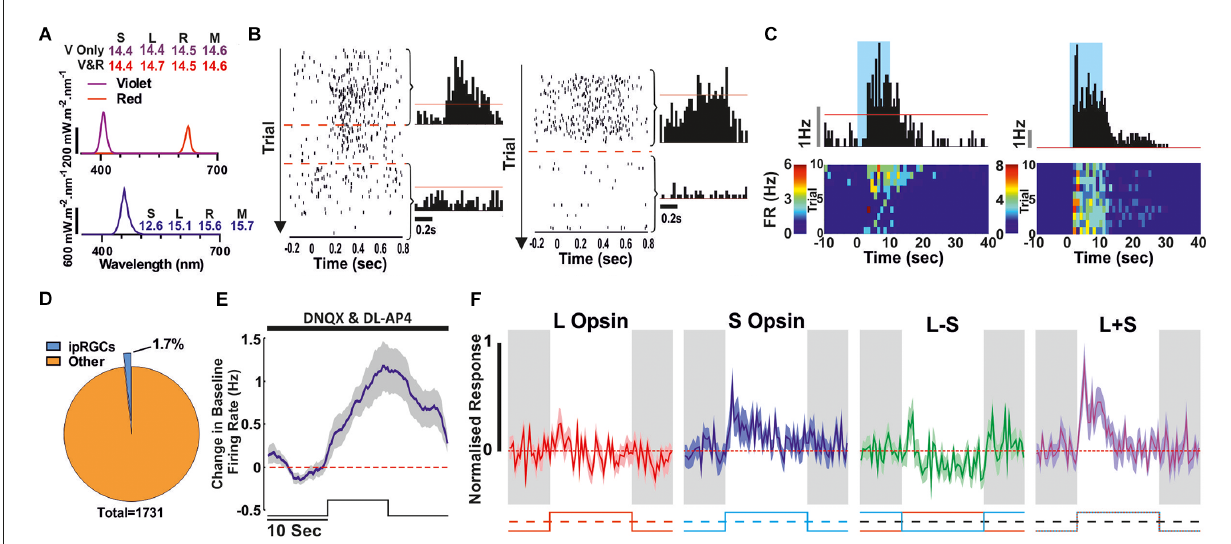
FIGURE3 Synaptic blockade (DNQX and DL-AP4) to confirm ipRGCs. (A) Spectra and Relative photon absorbance (log 10 photons) for each photopigment for the stimuli used here to check for extrinsic responses (rod or cone driven, top) and intrinsic responses (bottom). (B,C) Two example ipRGCs. (B) Rod/Cone mediated responses to a 500 ms light step (ISI: 500 ms; Violet or Violet and Red light) before and during the drug application which abolishes the RGC responses from the outer photoreceptive layer. Left raster plot, red lines denote the first and last 200 trials that were